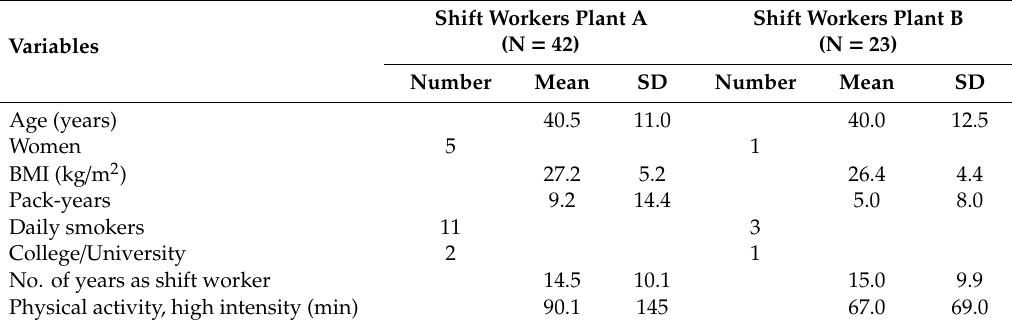
Table 1. Demographic characteristics among shift workers (N = 65) participating in the study.